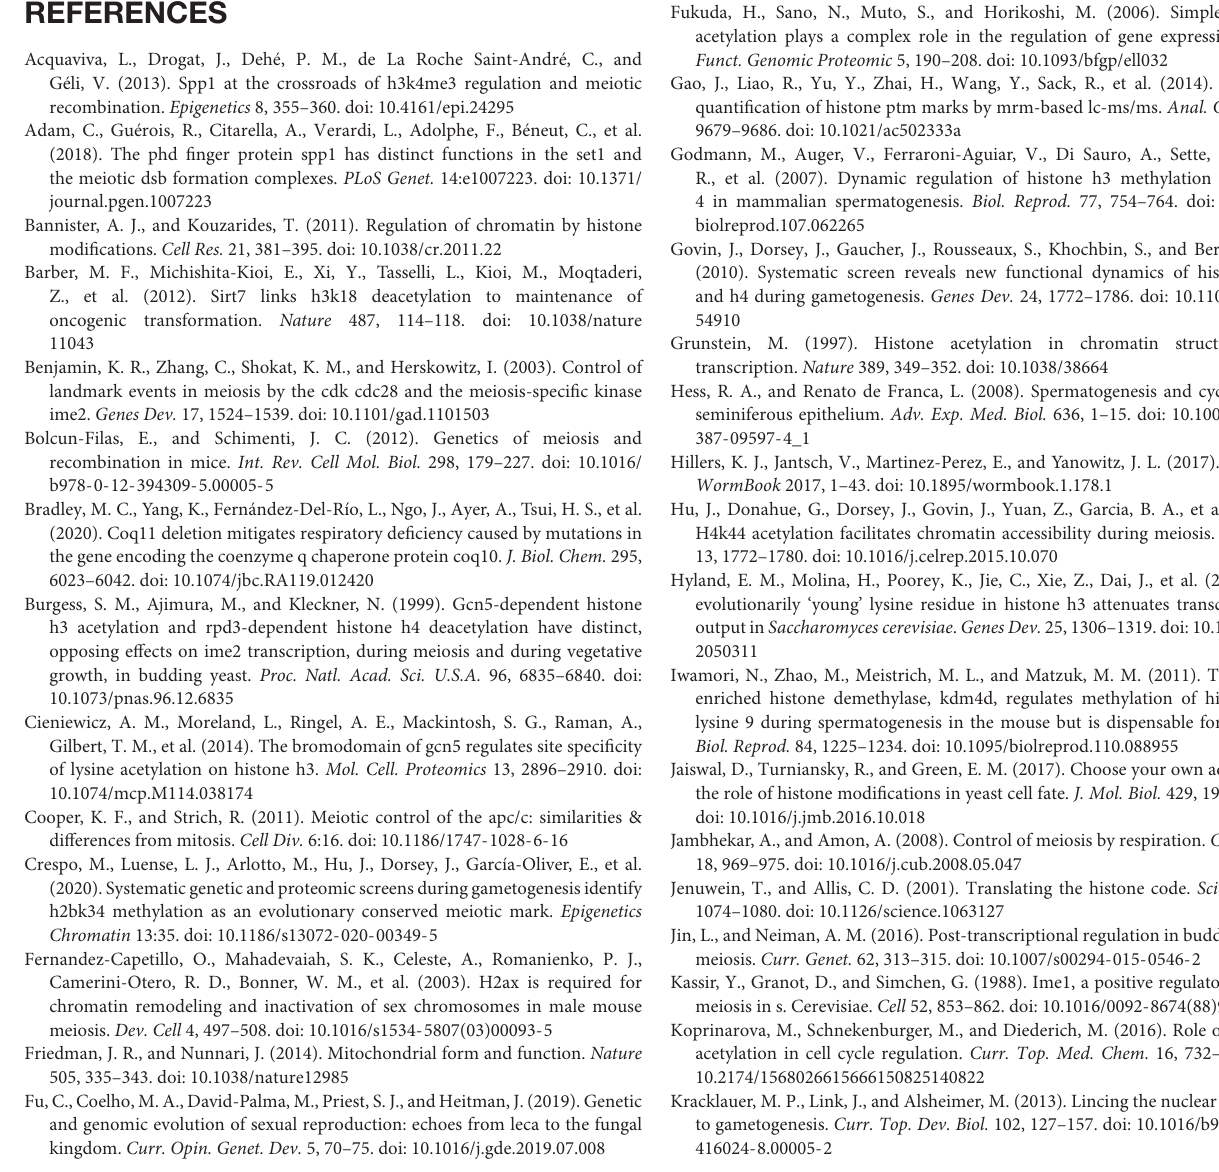
detected. 5-FOA was used to remove the plasmid expressing wild-type histone H3. Pgk1p was used as a loading control. Supplementary Figure 3 | Less zoomed-in versions of the sporulation images about the representative sporulation defect strains in Figure 3B . Supplementary Figure 4 | Western blot verification of the generated of histone H3 mimic strains. (A–G) The modification mimic histone H3 could be expressed and the original wild-type histone H3 plasmid was removed using negative section with 5-FOA. Pgk1p was used as a loading control. Supplementary Figure 5 | Modifications mimic strains to rescue the sporulation rate of H3K9A and H3K14A mutant strains. (A) Sporulation efficiencies of mutant cells mimic different histone modifications. The error bars indicate ± SD ( n = 3). * P < 0.05, ** P < 0.01. WT: LW0066; H3K9A: LW1601; H3K9L: LW1618;